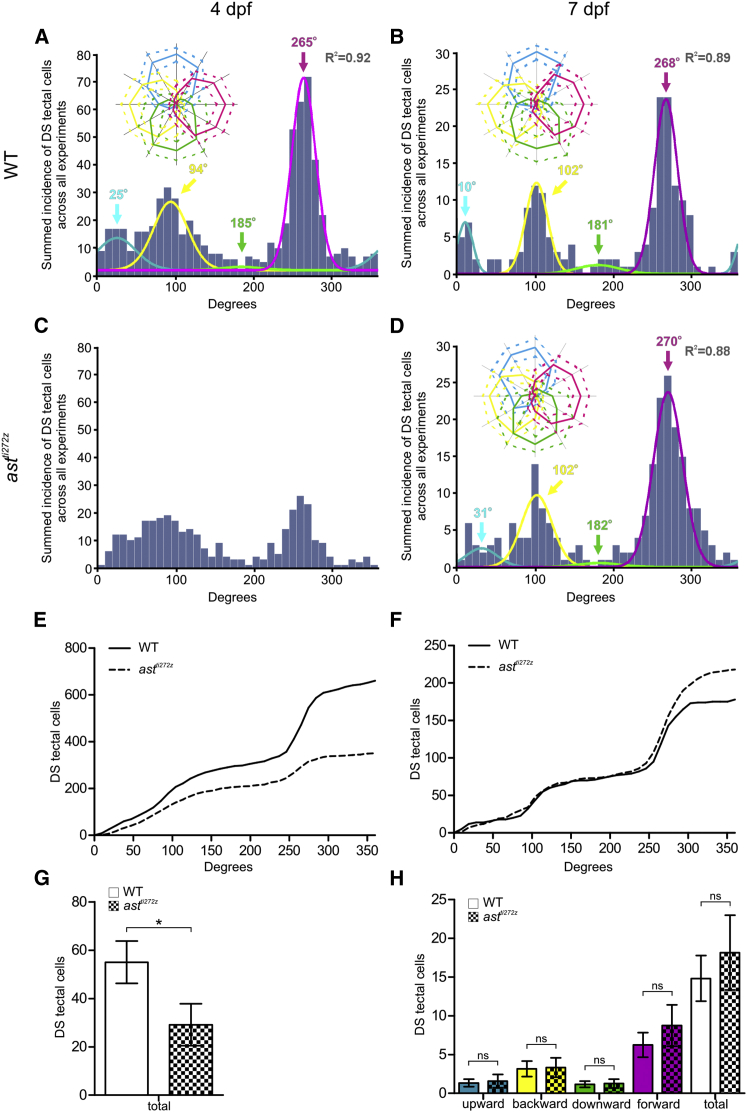
Functional Development of DS Tectal Cells Is Delayed in astray MutantsFunctional imaging of tectal cell responses in WT (n = 12, total of 36 optical sections) and astti272z (n = 12, total of 36 optical sections) larvae with pan-neuronal expression of GCaMP5G (Tg(elavl3:GCaMP5G)).(A–D) Cumulative histograms summarizing the incidence of preferred angles for DS tectal cells in WT larvae at 4 dpf (A) and 7 dpf (B), and astti272z larvae at 4 dpf (C) and 7 dpf (D). Overlaid colored curves in (A), (B), and (D) show fitted von-Mises distributions used to identify the four DS subtypes and the color-coded arrows represent peak preferred angles. R2 values relate to the summed von-Mises distributions. Insets in (A), (B), and (D) show polar plots of the mean (solid line) ± 1 SD (dashed line) normalized responses of cells within each DS subtype. Note that the same functional subtypes are present at 4 and 7 dpf in WT tecta.(E and F) Cumulative plots generated from the data in (A)–(D) comparing the incidence of preferred angles for DS tectal cells between WT and astti272z larvae at 4 dpf (E) and 7 dpf (F).(G and H) Quantification of DS tectal cell number at 4 dpf (G) and 7 dpf (H). Note the significant reduction in DS tectal cell numbers at 4 dpf, but recovery at 7 dpf. All graphs show mean values ± SEM. ∗p < 0.05; ns, not significant, unpaired t test. See also Figures S4 and S5, Table S2, Movies S3 and S4.